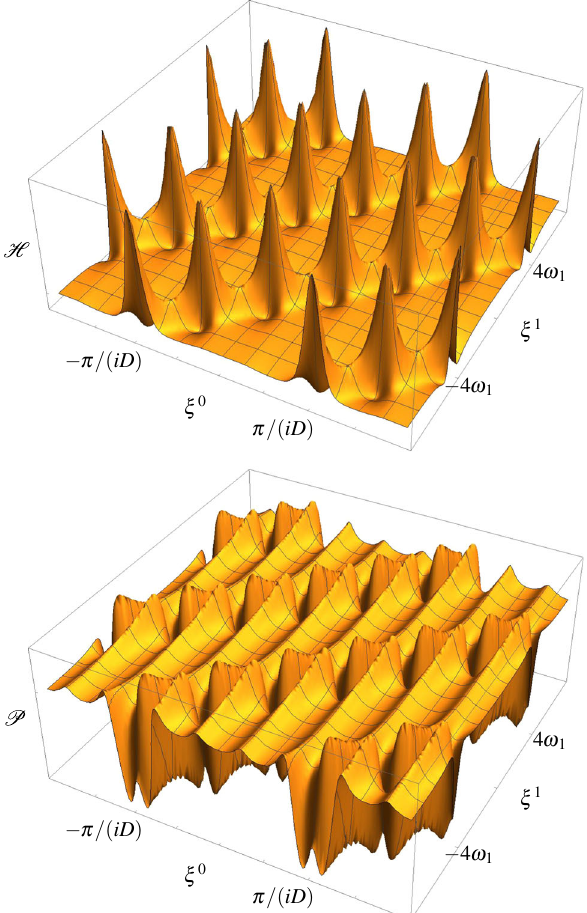
Fig. 10 The energy and momentum densities for a solution with D 2 < 0, seed energy density E = 3 μ 2 / 2 and Bäcklund parameter a = 1 . 45482, corresponding to a periodic solution with c = 1 / 2